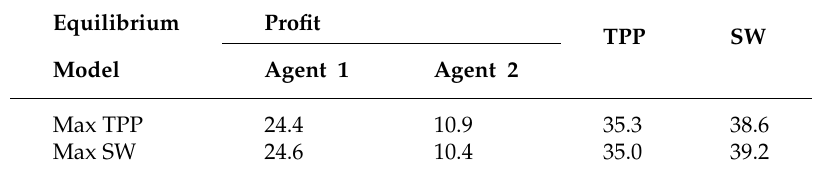
Table 1. Example: profits and social welfare ($ thousand) for two equilibrium